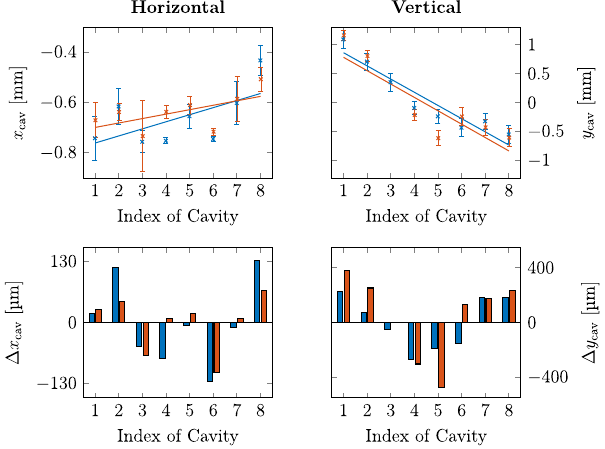
FIG. 16. HOM-based cavity misalignment measurements for the horizontal (left) and vertical (right) planes. The results of two independent measurement shifts are plotted in red and blue, respectively. The upper plot shows the calculated cavity center u (dots) and the deduced module axis (lines) with respect to the cav BPM reference axis. The middle row illustrates the residual cavity offset Δ u with respect to the calculated module axis. cav